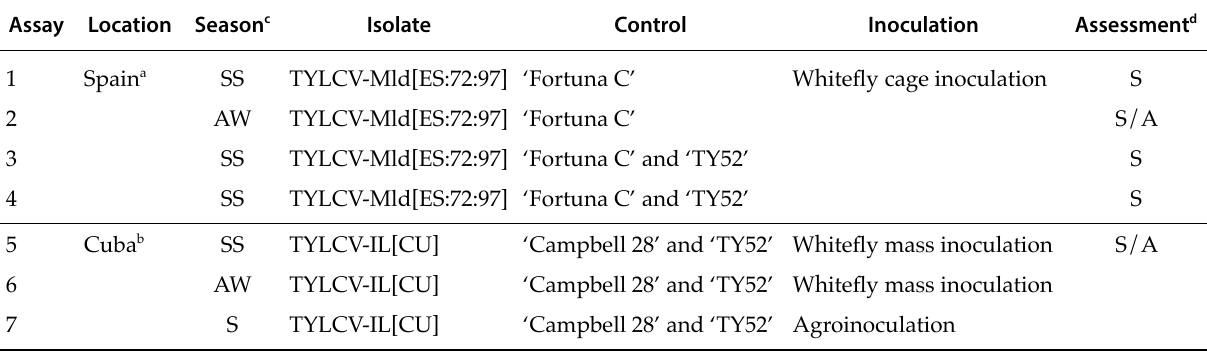
Table 1. Environmental conditions, inoculation method and disease assessment used in the different assays described in this